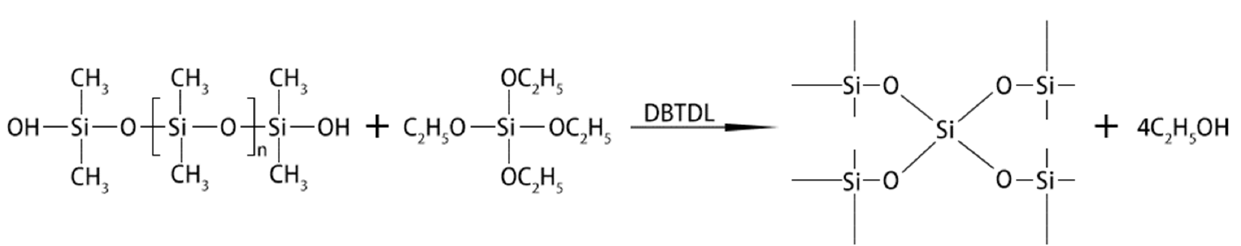
Figure 3. Vulcanization reaction of Room temperature vulcanized silicone. DBTDL: dibutyltin dilaurate.